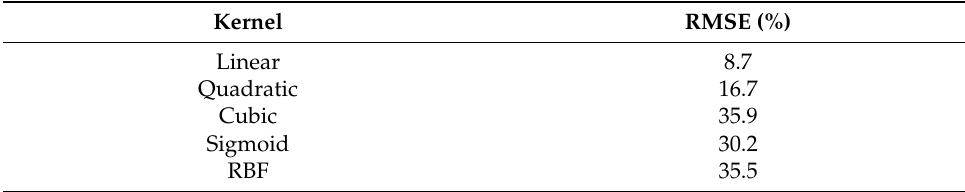
Table 2. RMSE results for four main types of SVM kernels on the “NN drive cycle” training dataset tested on the US06 drive cycle